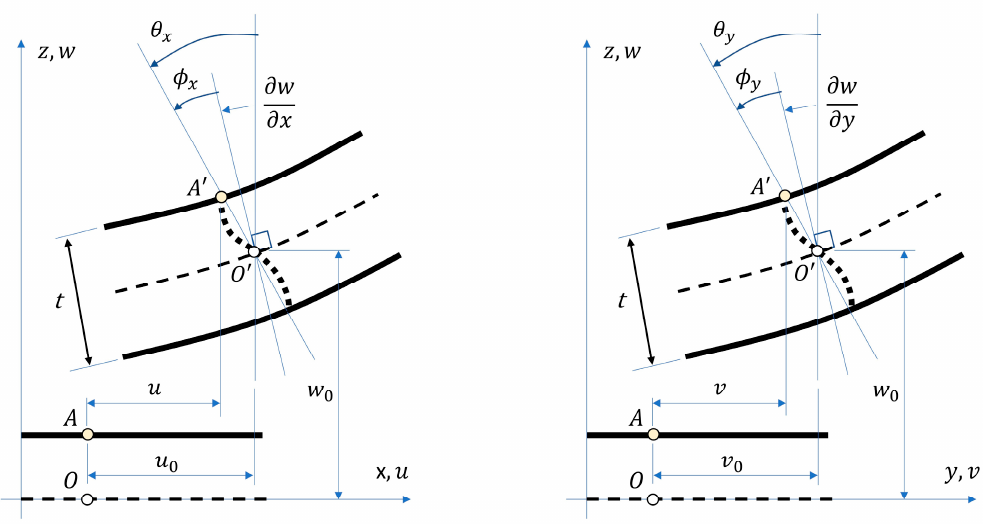
Figure 3. The displacements and the rotations of the normal-sign convention in Reissner–Mindlin plate theory.